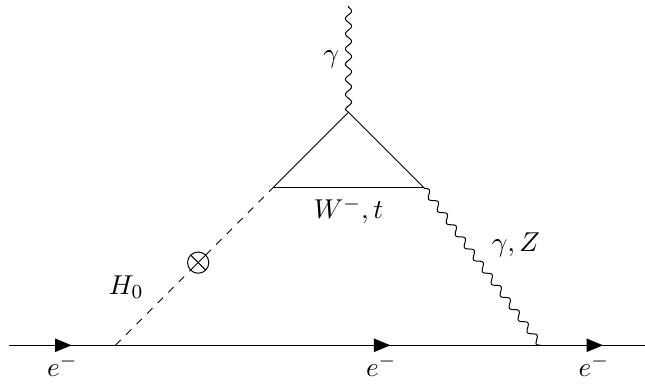
Figure 5 . The two loop diagram giving the maximum contribution to the electron EDM in our model. Four such diagrams have to be calculated, corresponding to the choice of top quark or W boson in the inner loop, and the choice of H i γγ or H i Zγ as the bosons interacting with this inner loop. Here H 0 denotes the lightest mass eigenstate of the bidoublet